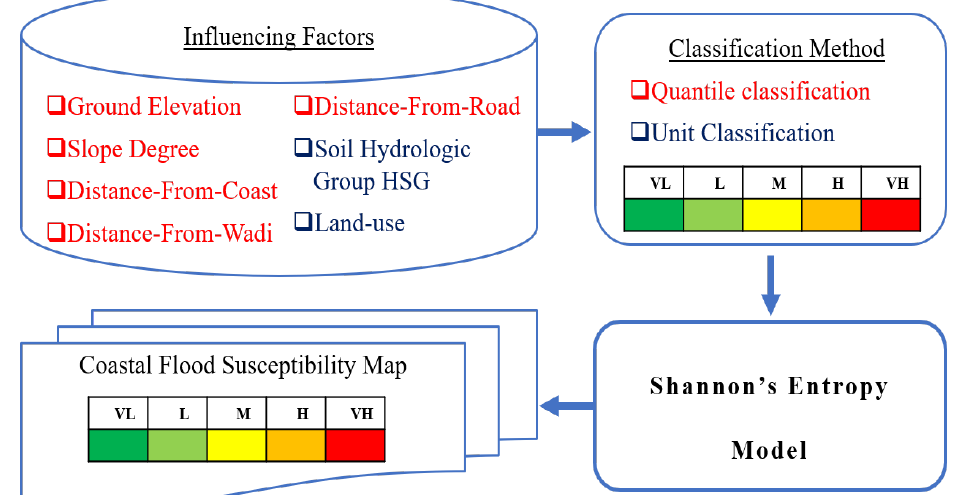
Figure 2. The methodology adopted for this study: (VL) is very low, (L) is low, (M) is moderate, (H) is high, and (VH) is very high .